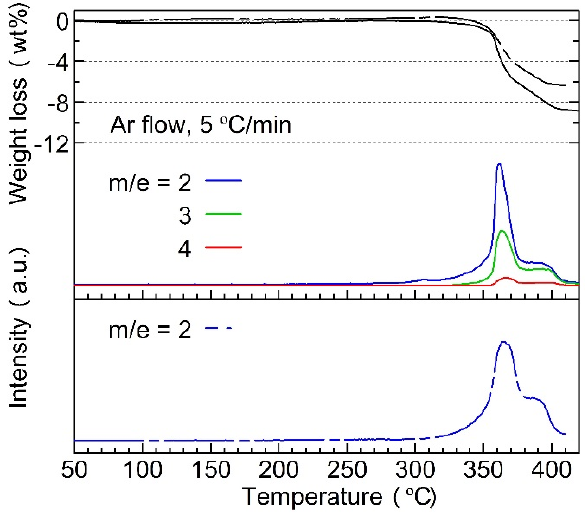
Figure 3. TG–MS profile of 0.75LiBH 4 + 0.25Mg 2 FeD 6 (solid line) and 0.75LiBH 4 + 0.25Mg 2 FeH 6 (dash